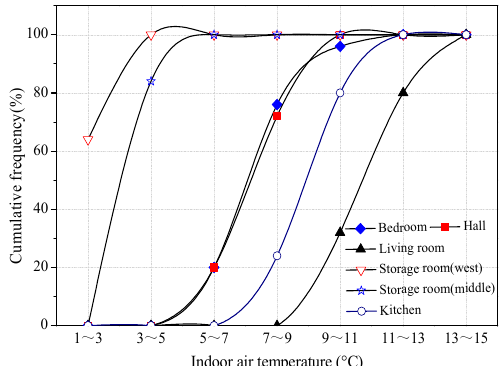
Figure 6. Frequency distribution of the indoor air temperature segments.